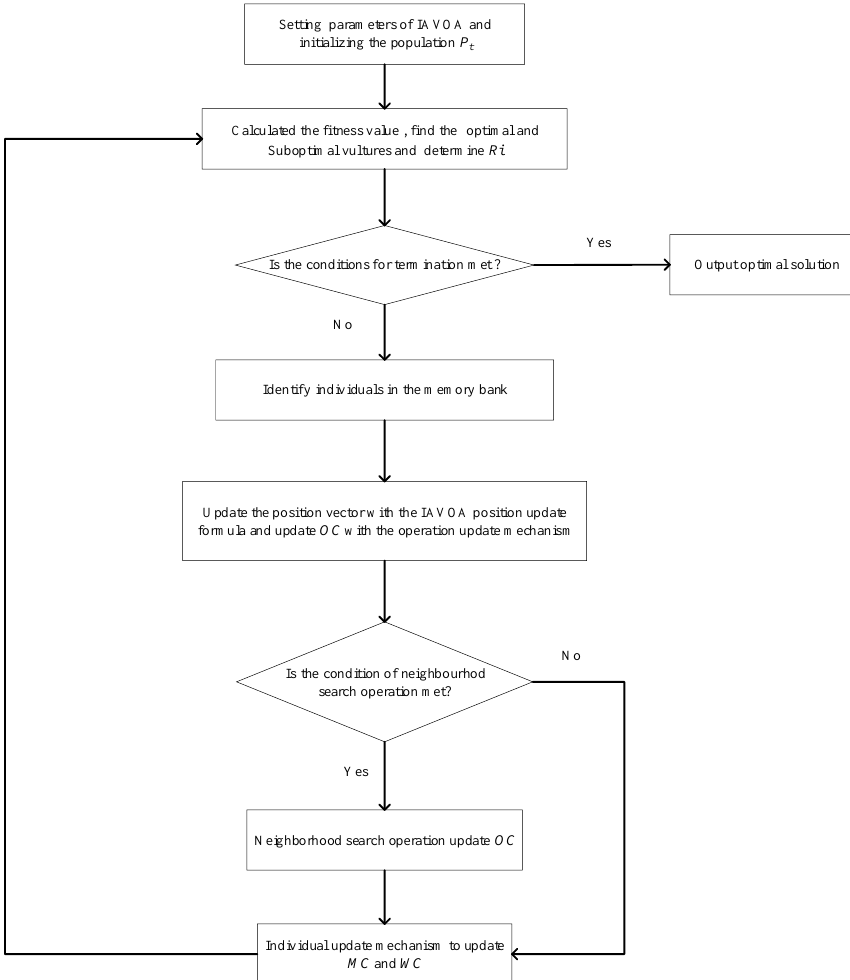
Figure 8. Flow chart of the IAVOA process.